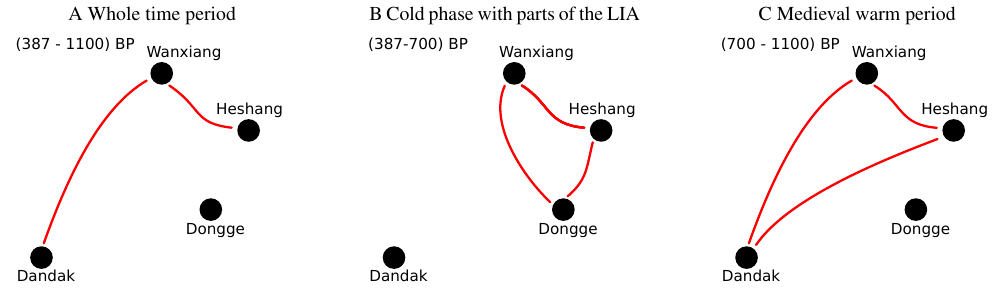
Fig. 14. Results from pairwise cross correlation analysis for all records: Red links indicate significant positive cross correlation at or close to zero lag for the respective records. While in the warm phase of the MWP the Northern Chinese records correlate with the Indian Dandak record and not with the southernmost Dongge cave record (B) , this is reversed in the cold phase after the MWP. The Chinese records then correlate amongst each other, but not with the Indian Dandak record (C) varying sampling irregularity. Compared to this, interpola- tion leads to an overestimation of this persistence time by a factor of two. This difference is especially unnerving as the frequency of observations recorded through paleo archives varies in dependence on climatic parameters (e.g. lower ac- cumulation rates through less precipitation). A change in the inter-observation time distribution could then lead to an arti- ficial change in the estimated persistence.